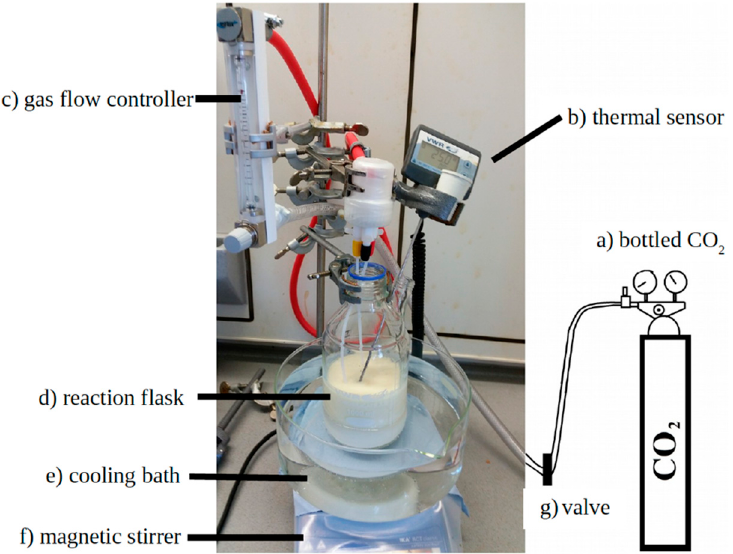
Figure A1. Experimental setup for B-AEP synthesis.